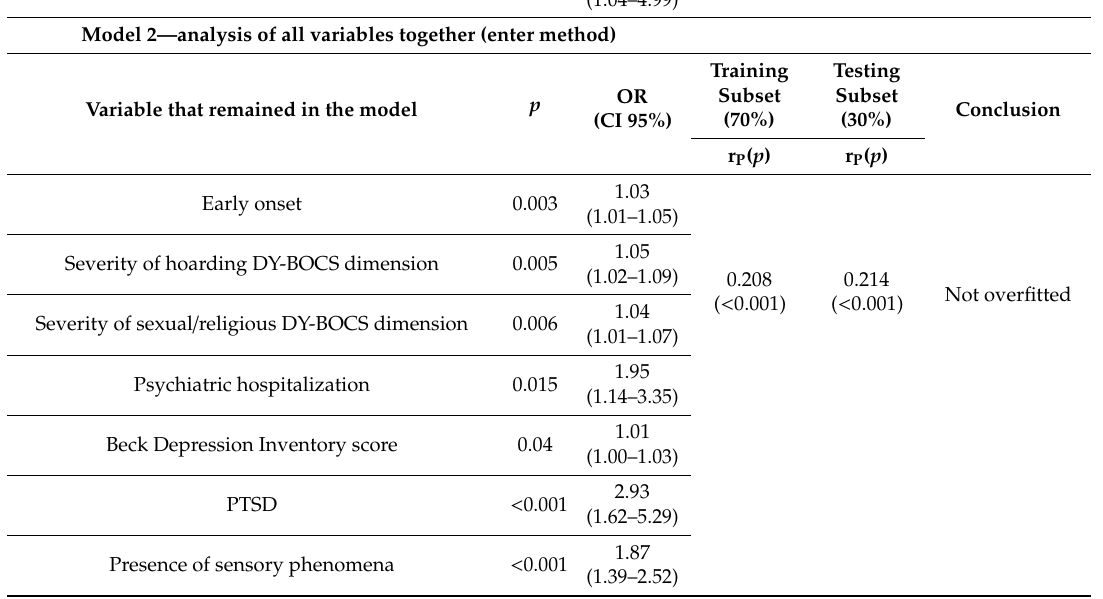
Table 4—psychiatric